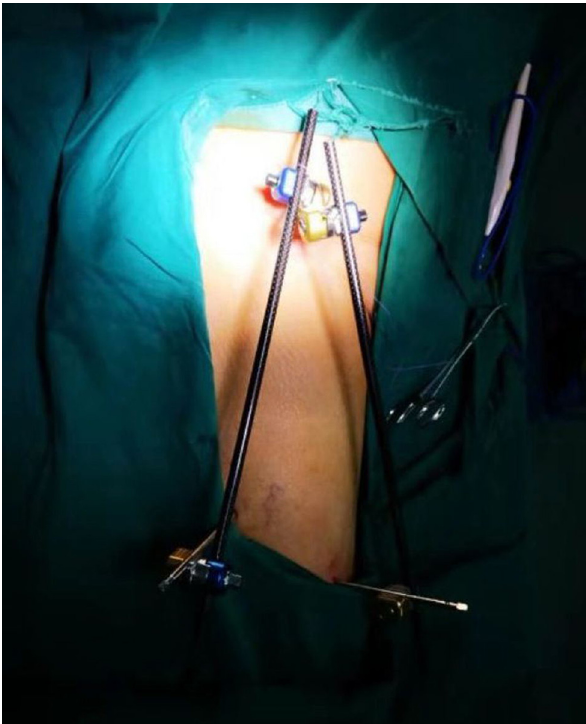
Figure 3: A patient with femoral intertrochanteric fracture was fi tted with an external fi xator during emergency surgery.